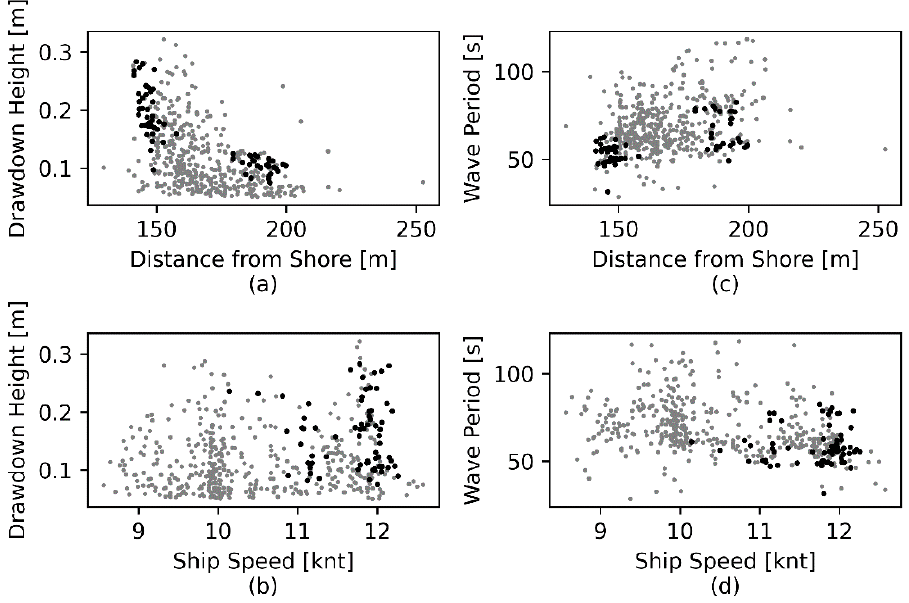
Figure 6. Drawdown height ( a,b ) and wave period ( c , d ) as functions of distance from the sailing line to shore and ship speed. Black dots mark a particular ship (Baltic Princess) and grey dots mark all the ships. As for the case of all ships, there seems to be a correlation between distance and drawdown when looking at a single ship. However, no strong correlation exists for ship speed.